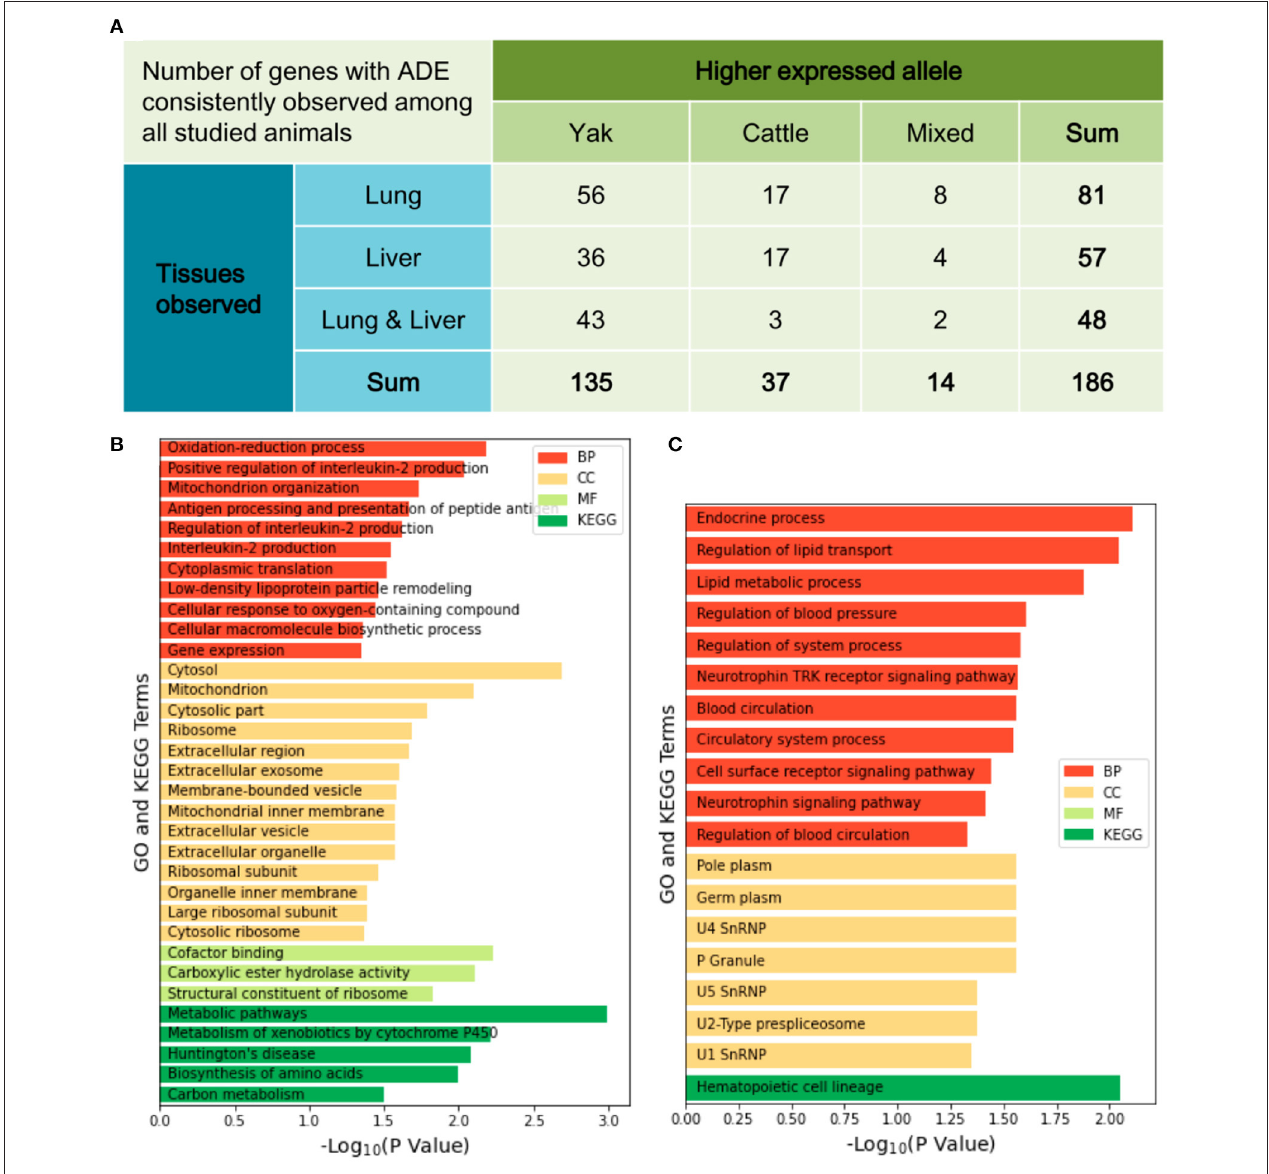
FIGURE 4 | The favoring direction and tissue distribution of allelic differential expression (A) . Functional analyses for 135 genes with the consistent higher expression of yak alleles (B) and for 35 genes with the consistent higher expression of cattle alleles (C) . BP, biological process; MF, molecular function; CC, cellular component; KEGG, Kyoto Encyclopedia of Genes and